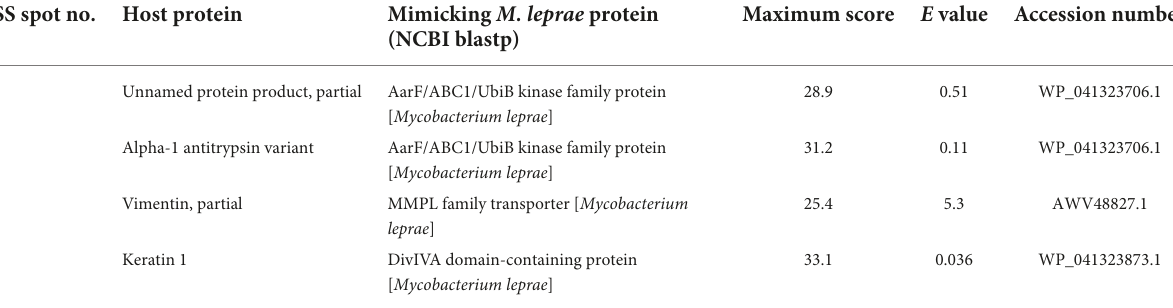
TABLE 5 The mimicking slit skin scrapings proteins of the host homologous to Mycobacterium leprae proteins. SSS spot